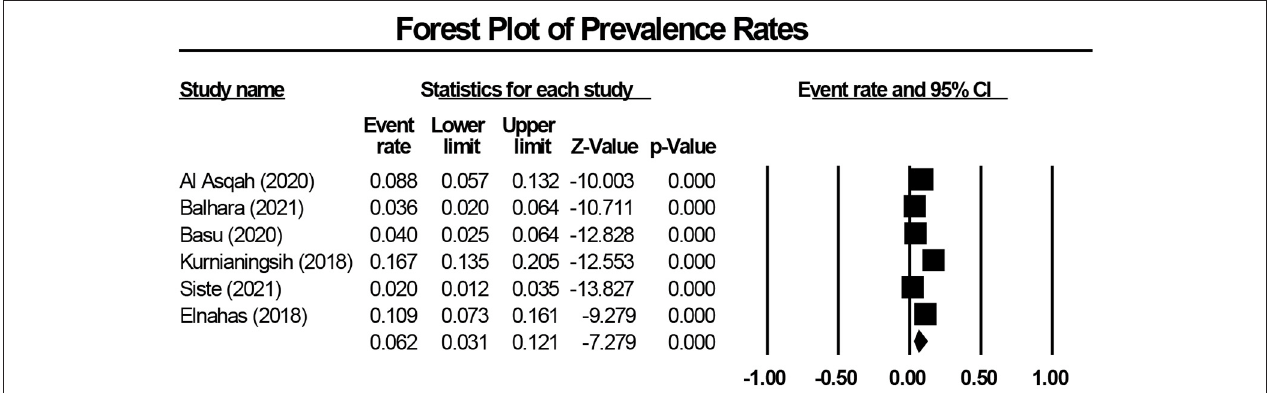
FIGURE 2 | Forest plot of pooled prevalence of internet gaming disorder among medical students.